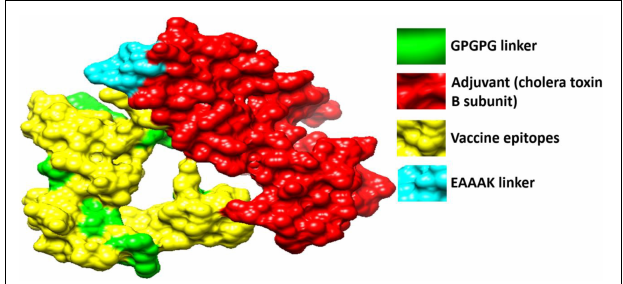
FIGURE 5 | 3D structure of the designed vaccine. The red color represents the adjuvant (cholera toxin B subunit), yellow color is for vaccine epitopes, cyan blue color denotes EAAAK while the green color is for GPGPG